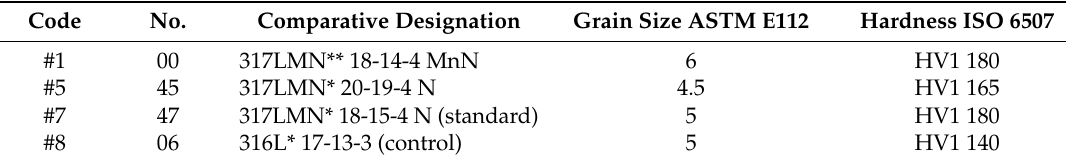
Table 2. Metallographic data.